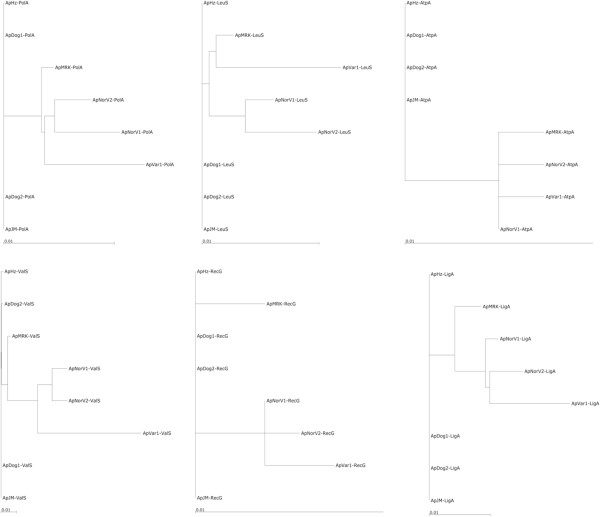
Phylogenetic tree to show the relationship of other conserved proteins from different strains of A. phagocytophilum. These proteins are: PolA, DNA polymerase I; LeuS, leucyl-tRNA synthetase; AtpA, ATPsynthase F1, alpha subunit; ValS,valyl-tRNA synthetase; RecG, ATP-dependent DNA helicase; LigA, NAD-dependent DNA ligase.